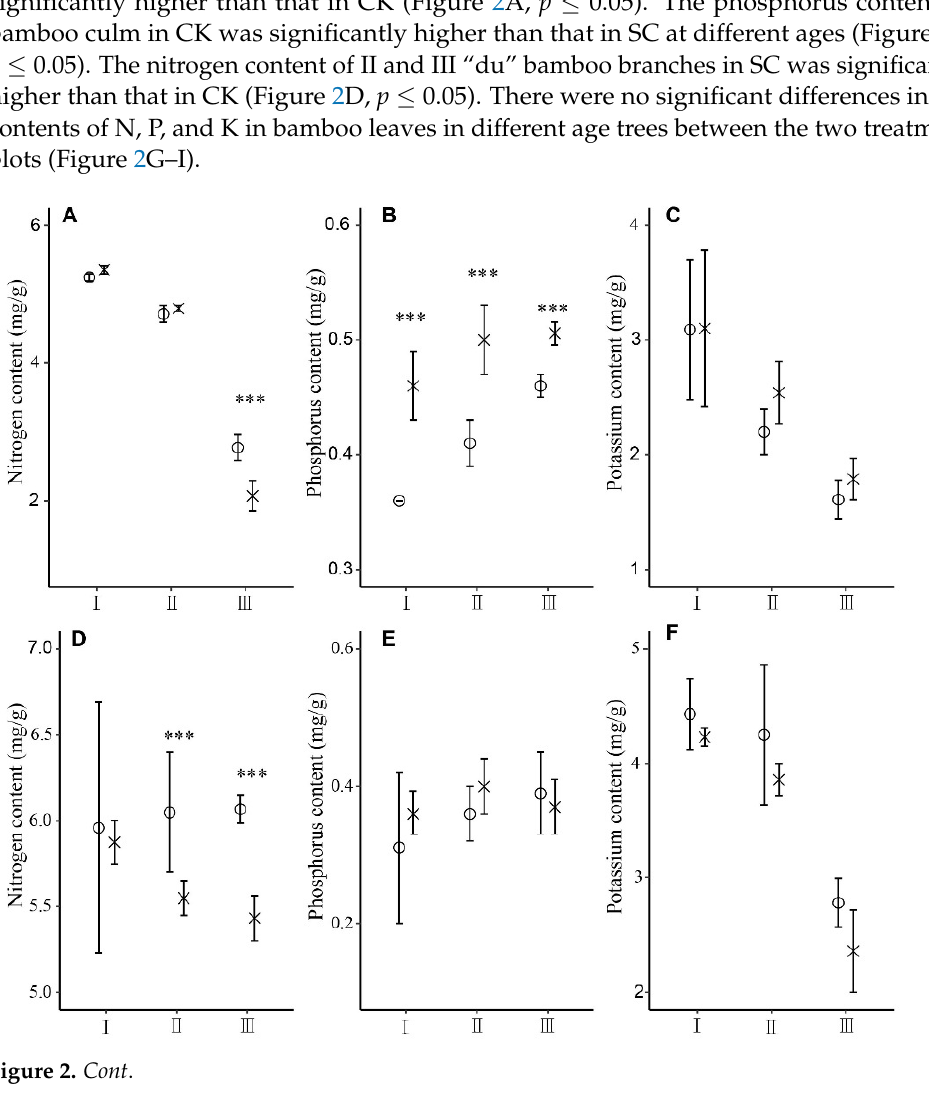
Figure 2. Nutrient content of Moso bamboo culm ( A – C ), branch ( D – F ), and leaf ( G – I ) at different ages at the two study sites SC (o) and CK (x). Error bars represent standard deviation (n = 3). Aster- isks indicate differences between study sites at different levels of significance: p ≤ 0.001 = ***; p ≤ 0.01 = **; p ≤ 0.05 = *. I “du” bamboo refers to a 1-year-old bamboo, II “du” refers to 2 − 3-year-old bamboo, and III “du” refers to 4 − 5-year-old bamboo. 3.3. Biomass Accumulation The biomass accumulation of each organ of Moso bamboo was culm > branch > leaf (Figure 3). After 5 years of restoration, there was no significant difference between the biomass accumulation of organs of Moso bamboo at different bamboo ages in SC and CK (Figure 3). The biomass accumulation of branches and leaves in III “du” trees was lower